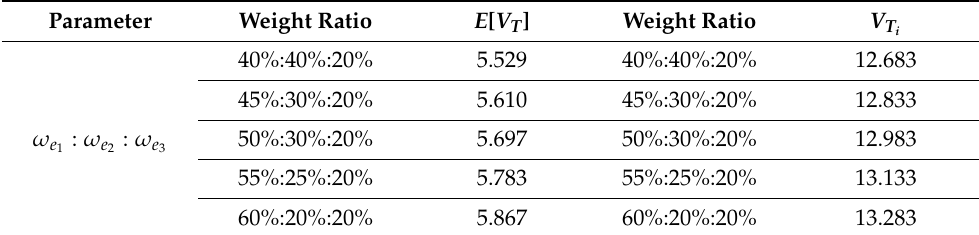
Table 9. Sensitivity analysis to estimate the proportion of total project value weight ratio. Currency: US$ Unit: million dollars.